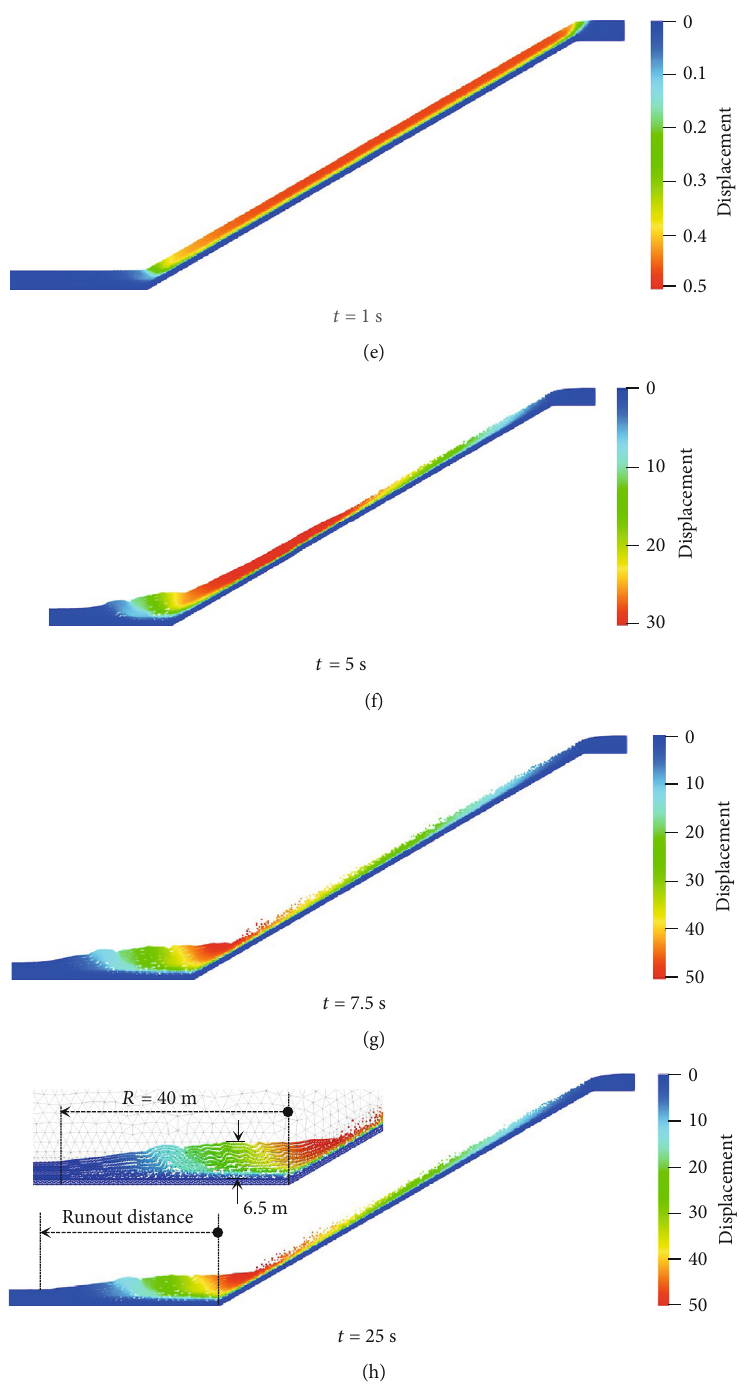
Figure 7: Progress of the landslide for baseline case in terms of: (a – d) deviatoric strain and (e – h) displacement contours at di ff erent